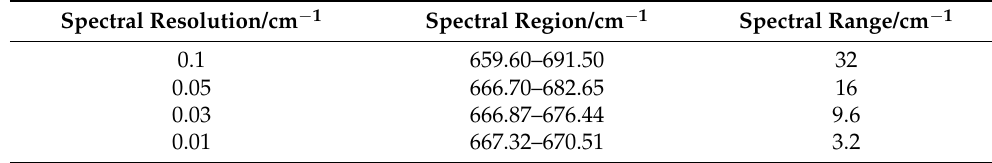
Table 2. The spectral region scheme of the single narrow